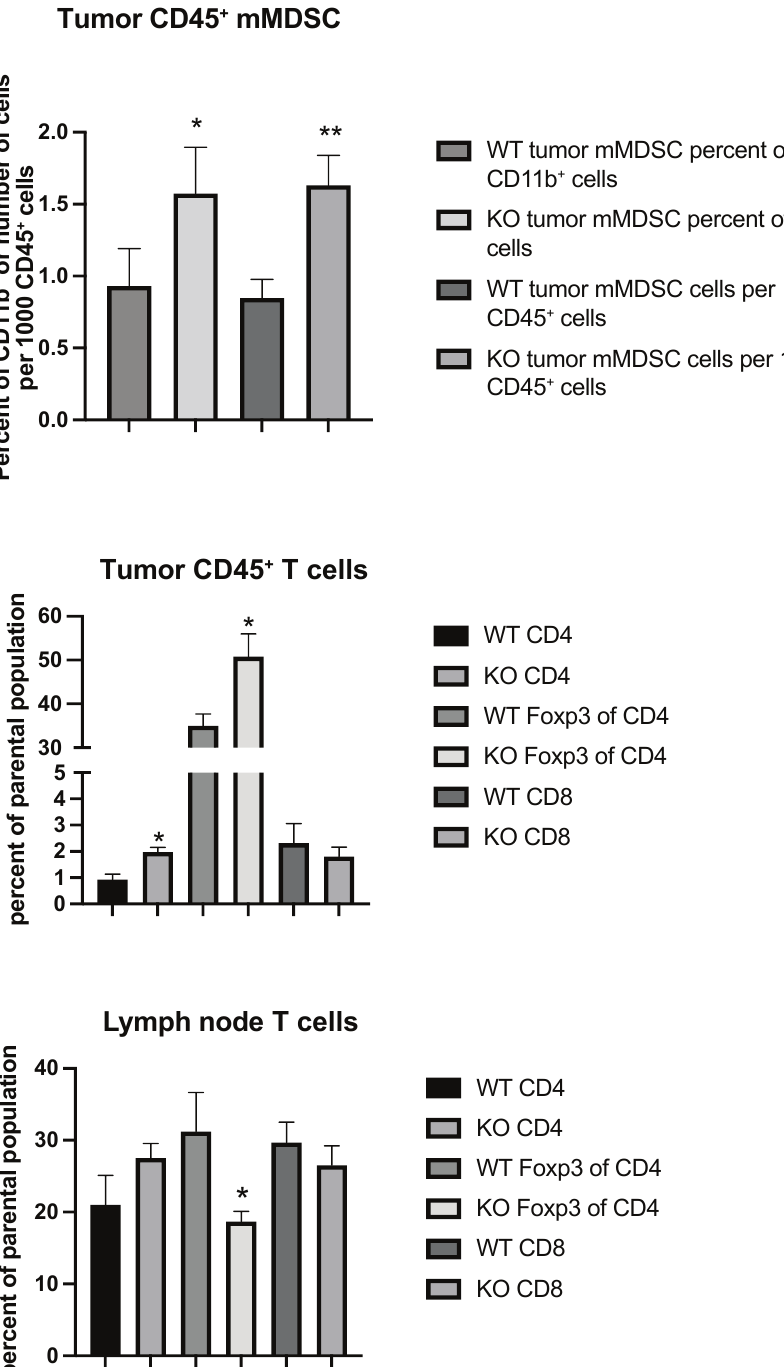
Figure 3. Tumor and inguinal lymph node immune cell profiling (mMDSC and T cells) using flow cytometry from wild type (WT) and EC Shb KO (KO) mice. Values are percent of parental population ± SEM. n = 6 for WT and n = 4 for KO. * and ** indicate p < 0.05 and 0.01 by Student’s t -test,